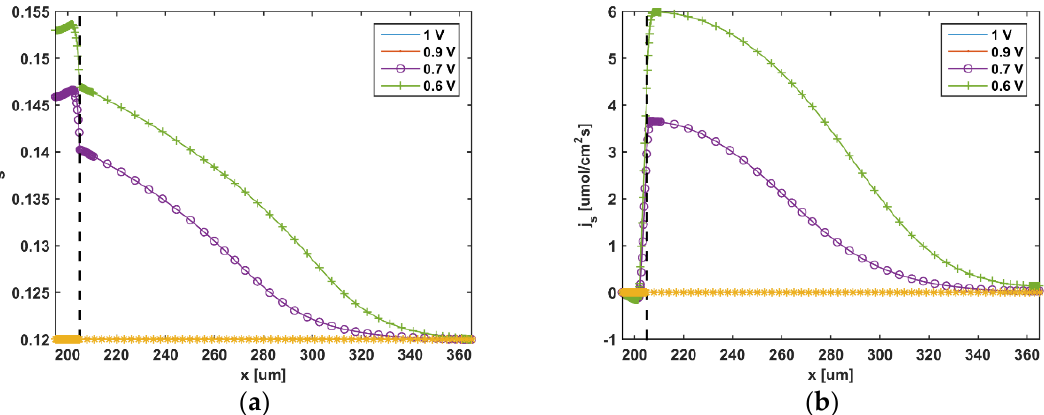
Figure 11. Evolution of the liquid water profiles on through-plane: ( a ) liquid water diffusion profile; ( b ) liquid water flux profile.